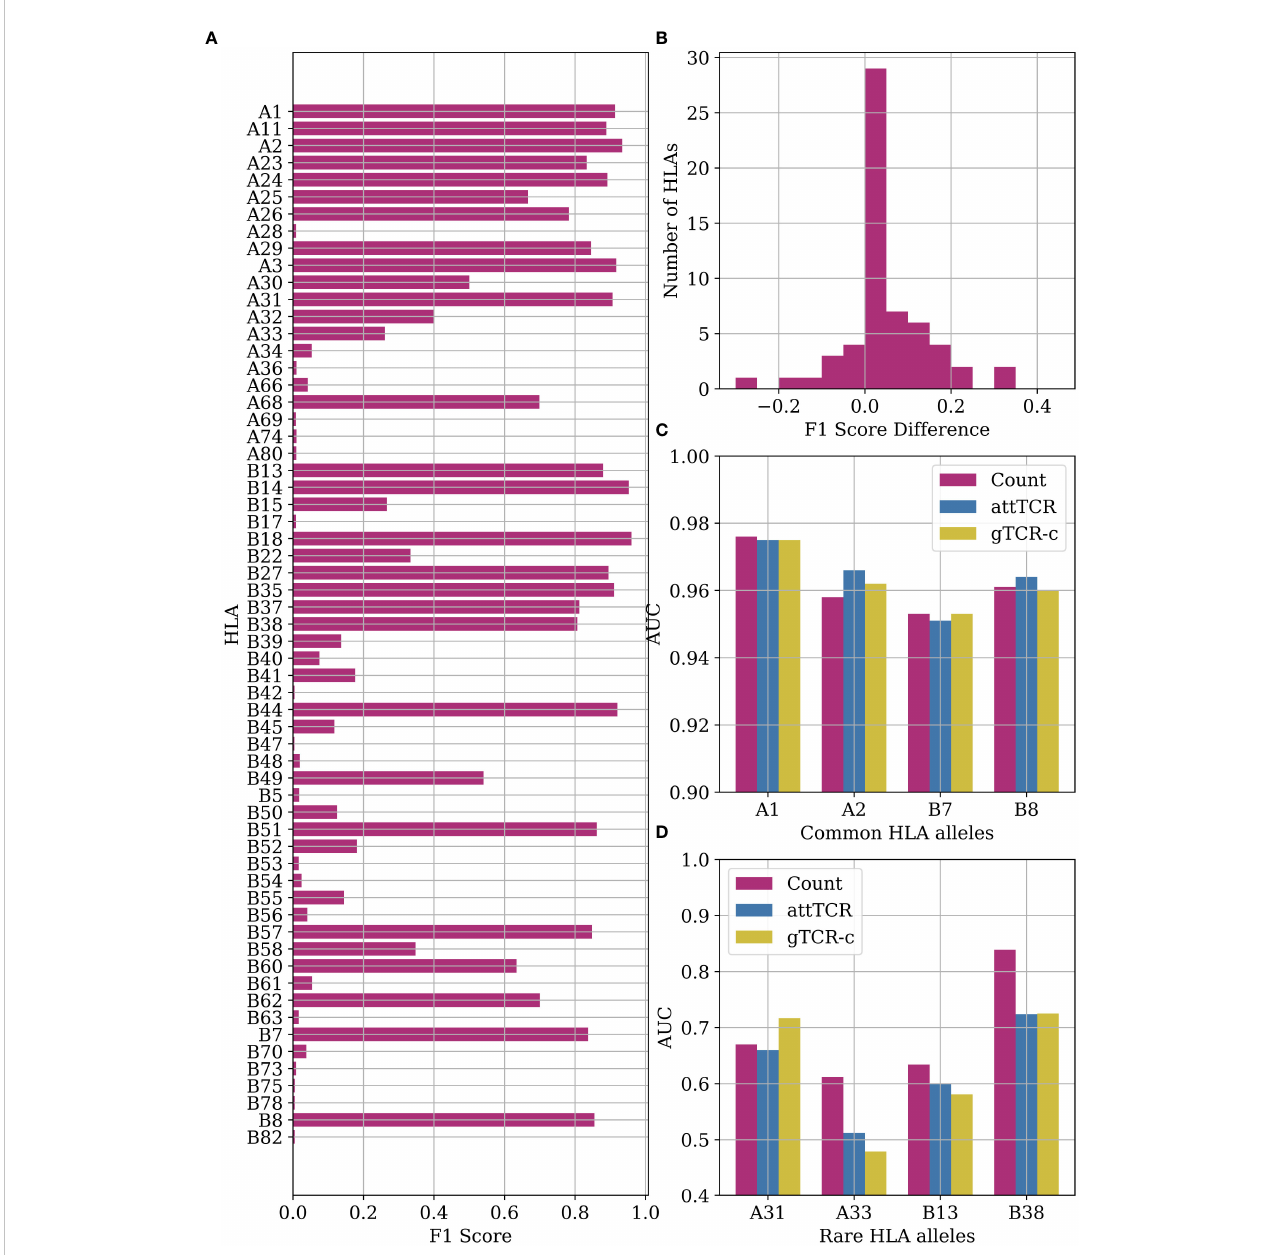
FIGURE 6 (A) F1 score results for the counting model on HLA classi fi cation. We performed a leave-one-out split over the entire dataset. (B) A histogram of the F1 score differences between the classi fi cation results of the counting model and the Emerson model. The difference between the counting model and the Emerson model is statistically signi fi cant ( p =0.017 with Mann-Whitney U-test) (4) on the same HLA alleles. (C) Comparison of AUC results of the counting model, attTCR, and gTCR-c on the repertoire HLA classi fi cation task. A 5-fold CV was used, and the AUC was calculated using prediction pooling instead of averaging (26). The HLA alleles presented are the most frequent HLA alleles in the dataset. (D) Comparison of AUC results of the counting model, attTCR, and gTCR-c on the repertoire HLA classi fi cation task. The HLA alleles presented are the least frequent in the